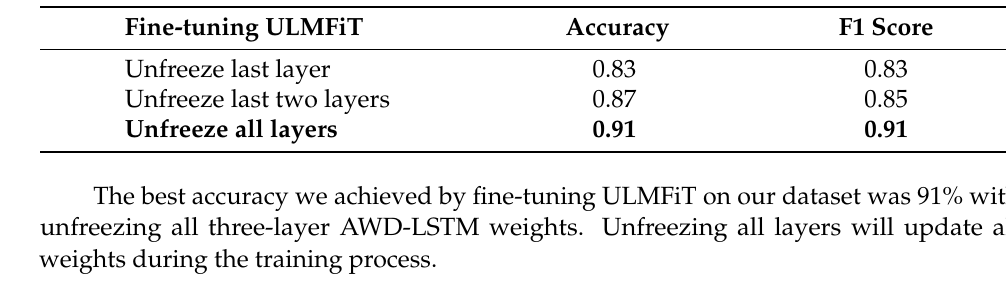
Table 7. Fine-tuning ULMFiT.